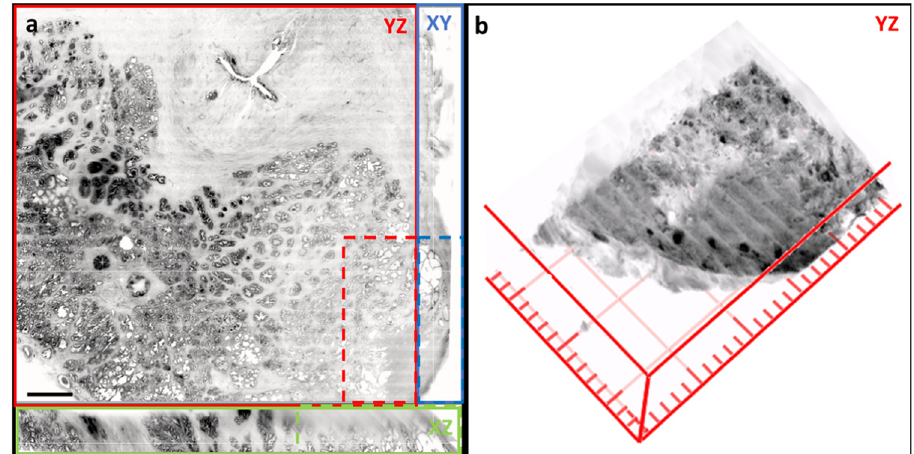
Fig. 7 3D rendering and 2D surface view of ct-dSPIM Mosaic 16 prostate cancer sample. Sample from Fig. 8e – h, is shown here in 2D ( a , one layer across the complete surface in yz shown in the red box, including 2 orthogonal sections across the complete sample thickness in indicated by green ( xz ) and blue ( xy ) boxes. Dashed boxes indicate the tumour (as identi fi ed by pathologist). The tumour region of this sample (red dashed box in a) is also shown in b as a 3D volume rendering. Scale bar: a, 3 mm; b, one square of the red grid 1